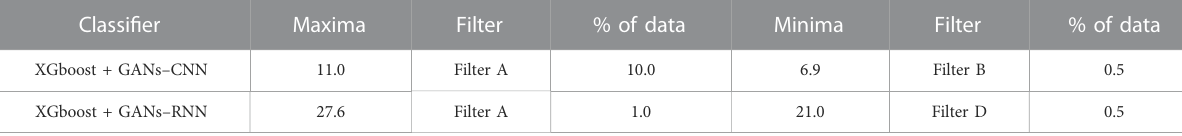
TABLE 10 Enrichment Ratios of OPRK1 on the original dataset with no feature selection with training size of 30%. Classi fi er